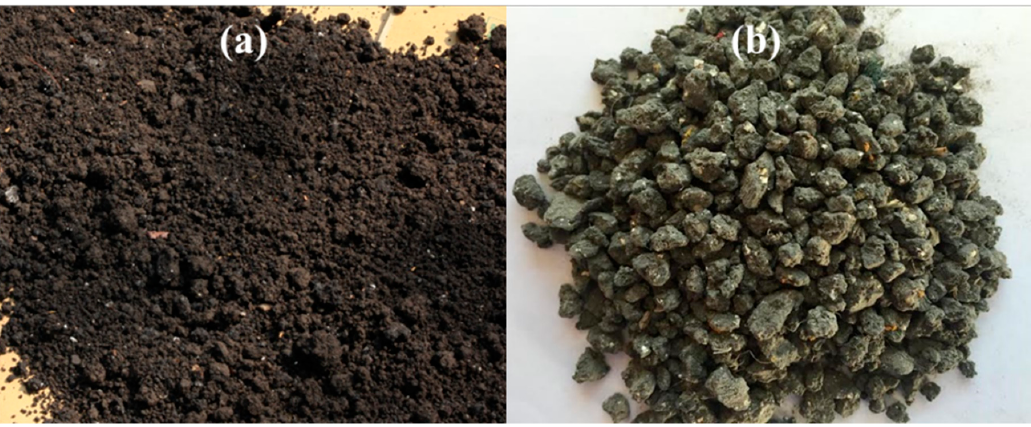
Figure 1. Photograph of sewage sludge, ( a ) sludge from the wastewater treatment plant and ( b ) sludge after preheating. Table 1. Proximate analysis of sewage sludge.